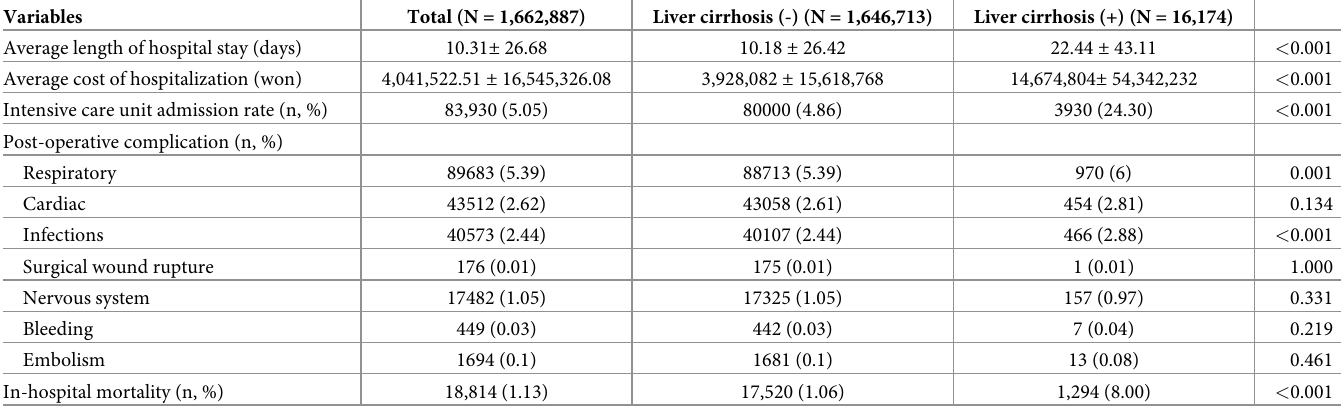
Table 2. Clinical outcomes of the